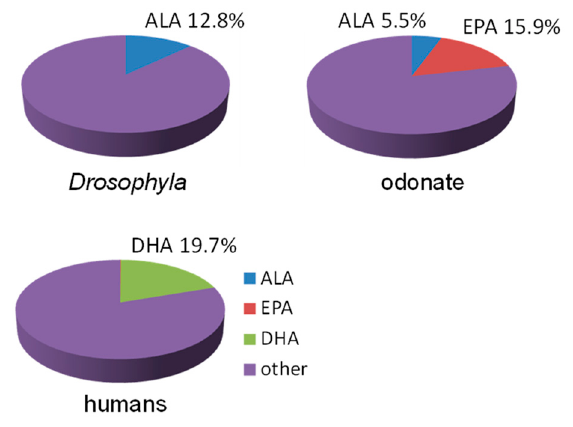
Figure 3. Levels (% of total fatty acids) of alpha-linolenic (ALA), eicosapentaenoic (EPA) and docosahexaenoic (DHA) acids in the heads of Drosophila [67], the eyes of odonates [68] and human retinas [3].